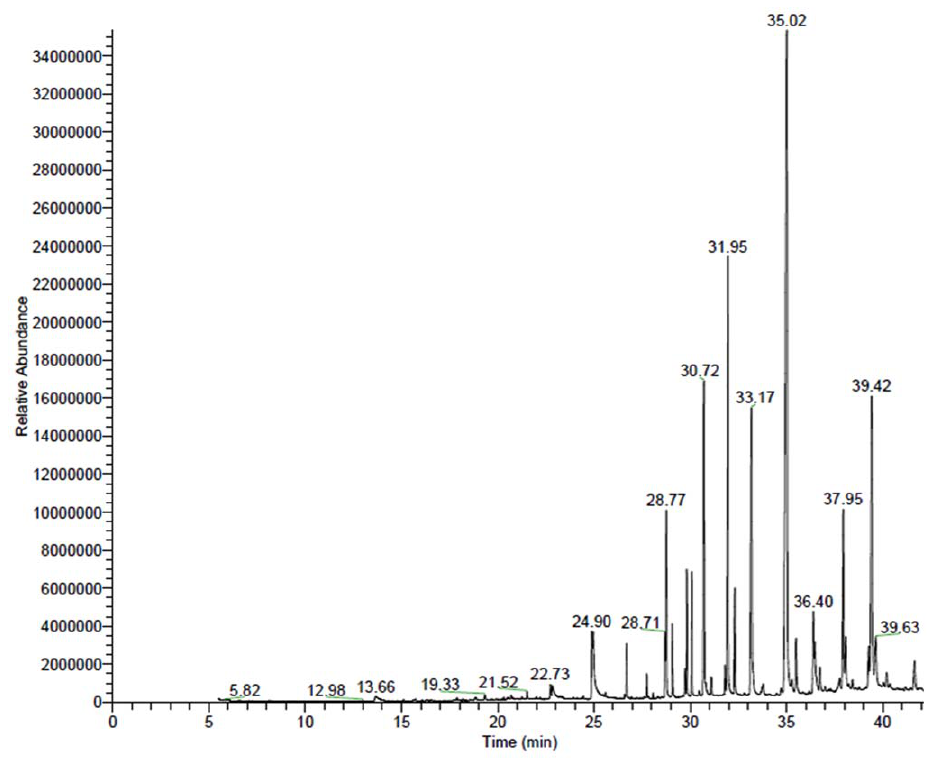
Figure 1. GC/MS chromatogram of n-hexane root extract of R.imbricata .